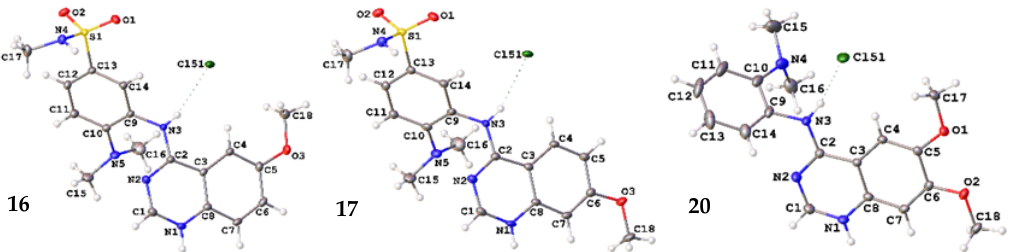
7 of 13 Figure 5. Docked 17 and 7 in the TNNi3K ATP binding site (PDB: 4YFF). WaterMap of 17 ( A ) and 7 ( B ) showing water molecules as spheres and WaterMap of 17 ( C ) and 7 ( D ) showing water molecules with hydrogen bonding networks. 2.6. Small Molecule Crystal Structures of 16 , 17 and 20 A crystallographic analysis revealed 16 , 17 and 20 crystallized as chloride salts (Figure 6) with 16 and 17 crystallizing in the triclinic P-1 space group and 20 crystallizing in the monoclinic I2/a space group. Each of the molecules comprise a planar quinazoline moiety and substituted aniline moiety. The quinazoline moiety, N1-N2 and C1-C8, exhibit root mean square (r.m.s) deviations between 0.011 Å ( 20 ) and 0.034 Å ( 16 ) with the maximum deviation from the plane being between 0.019 Å ( 20 ) and 0.0057 Å ( 16 ) for the aniline N-bonded C2 atom in all molecules. The r.m.s. deviation of the aniline moieties (excluding the dimethylamine and N -methylbenzenesulfonamide substituents) is between 0.021 Å ( 16 ) and 0.059 Å ( 20 ) with the aniline N-atom bonded C9 displaying the maximum deviation